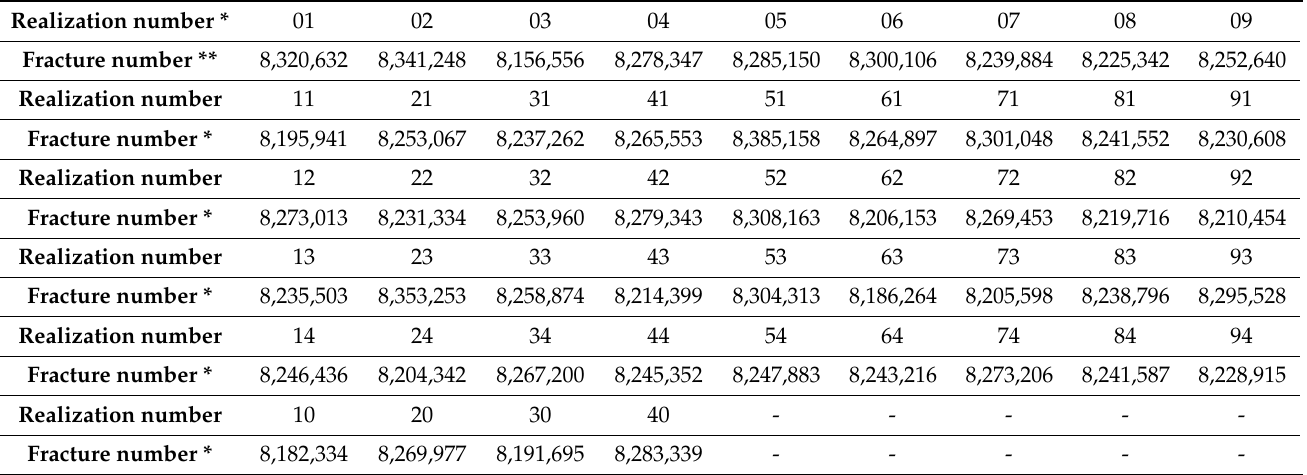
Table 5. The effective fracture numbers of the 49 DFN